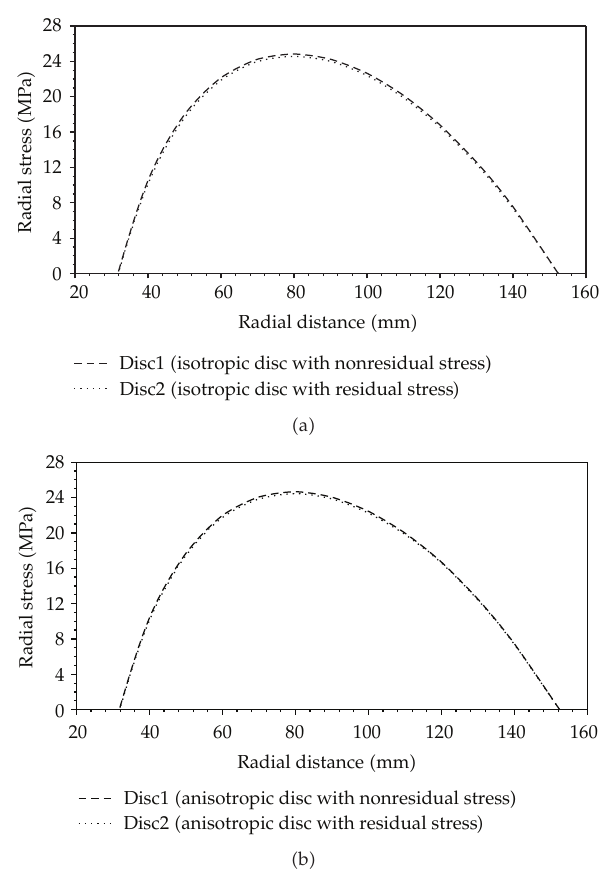
Figure 4: Variation of radial stress along the radial distance in isotropic/anisotropic discs rotating with an angular velocity 15000rpm at